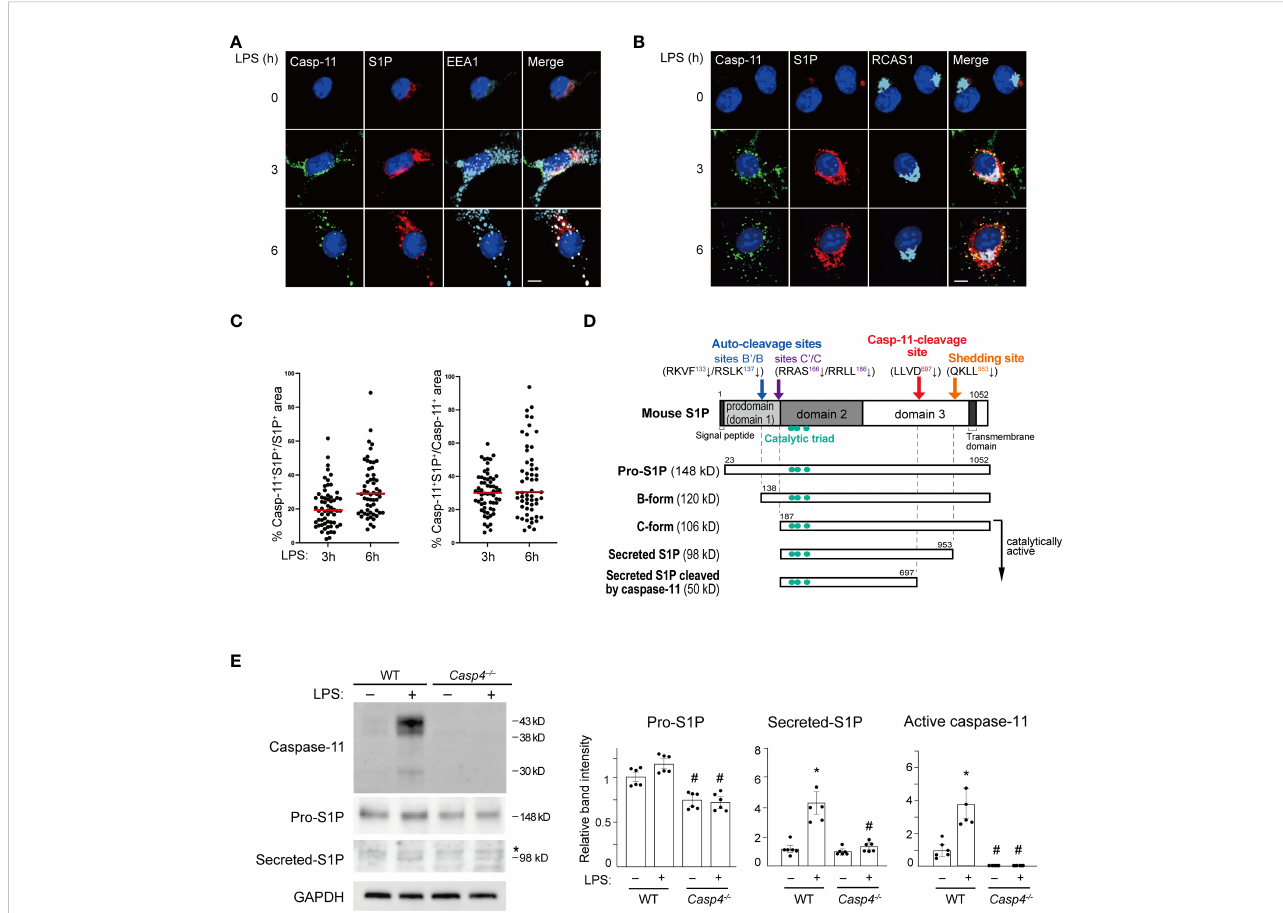
FIGURE 2 Caspase-11 promotes S1P processing. (A, B) BMDMs were treated with LPS for the indicated times. Caspase-11 (green), S1P (red), and the endosome marker EEA1 in A or the Golgi apparatus marker RCAS1 in B (light blue) were visualized by immuno fl uorescence staining. Nuclei were counterstained with DAPI. Scale bar, 10 mm. (C) Fractions of caspase-11- and S1P- double positive areas within S1P- or Caspase-11-positive areas. Sixty cells per each condition were analyzed. Caspase-11 signal was not detected without LPS stimulation. (D) A schematic representation of the processing of mouse S1P. (E) BMDMs from WT and Casp4 – / – mice were treated with LPS for 6 h. Caspase-11, S1P, and GAPDH expression in whole cell lysates were detected by western blotting. Asterisks indicate non-speci fi c bands. The relative band intensities corresponding to pro-S1P, secreted S1P, and active caspase-11